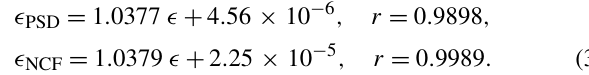
u 2 , Eq. (21), where the i i u 2 for the 200Hz signal with i i